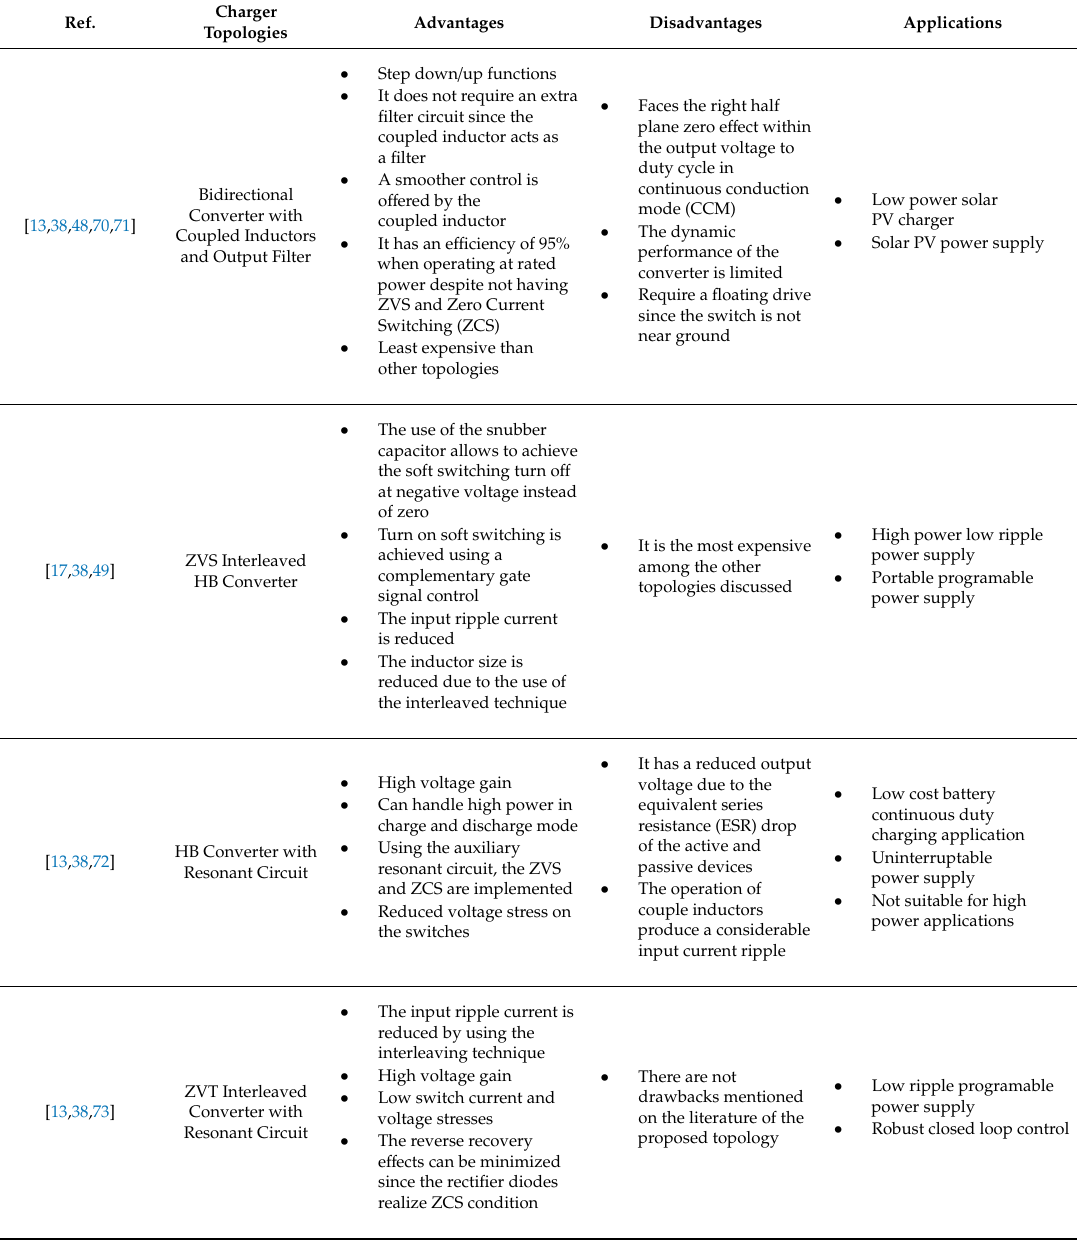
Table 4. Comparison of non-isolated bidirectional DC–DC converter topologies.